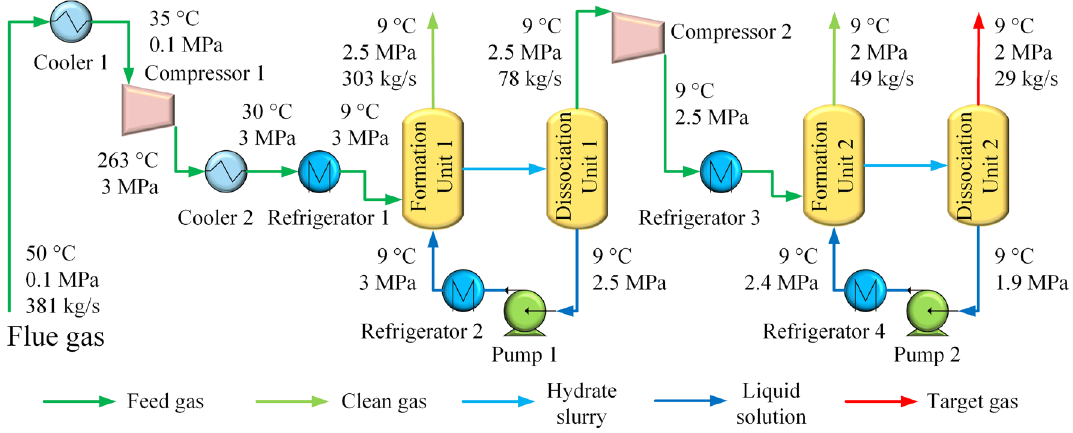
Fig. 2 Simulated results of the two-stage hydrate-based CO